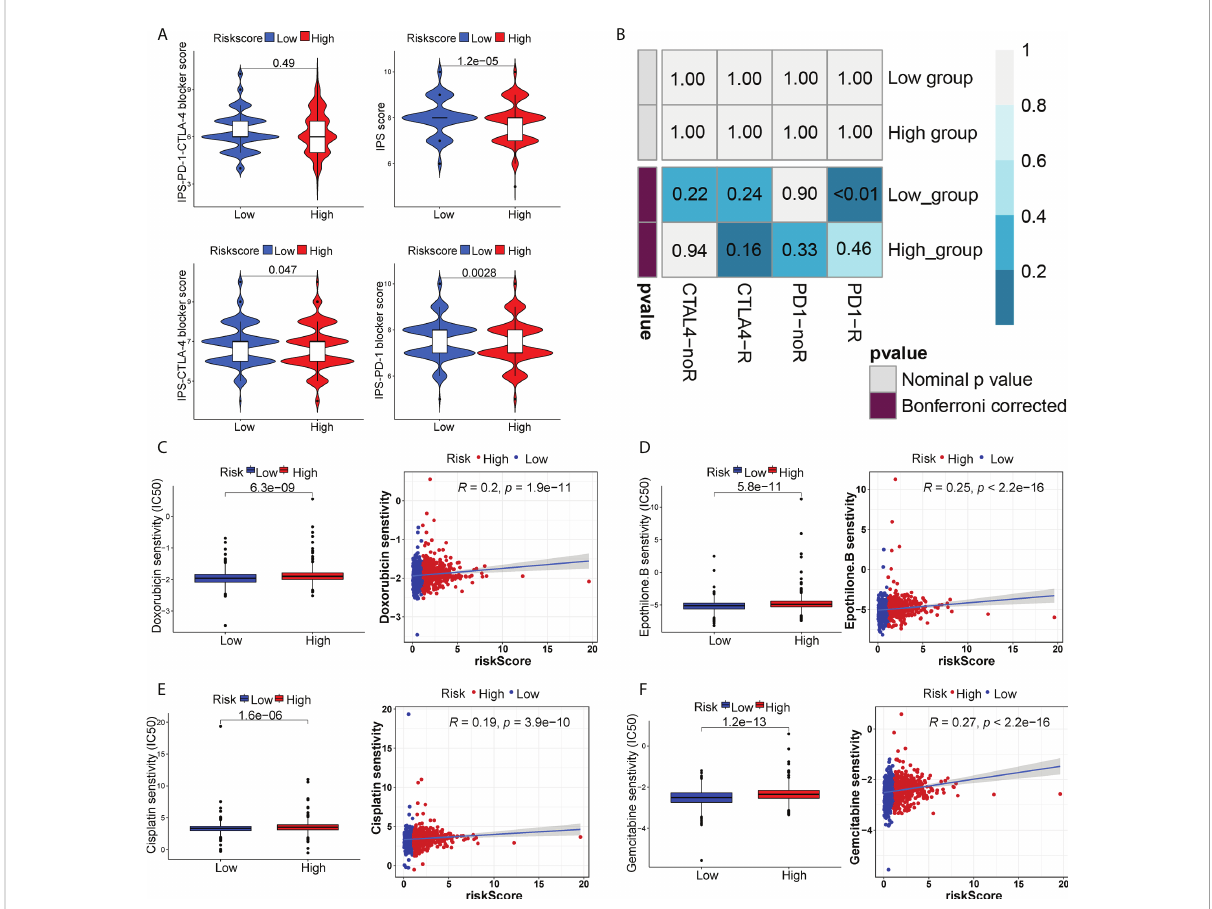
FIGURE 7 The distinct sensitivity to ICI therapy and chemo-drug therapy. (A) Four subtypes of IPS values (IPS score, IPS-PD1 blocker score, IPS-CTLA4 blocker and IPS-PD1-CTLA4 blocker). (B) The possible response to anti-PD1 and anti-CTLA4 immunotherapy in the two risk groups. Drug sensitivity of doxorubicin (C) , epothilone B (D) , cisplatin (E) and gemcitabine (F) in two risk